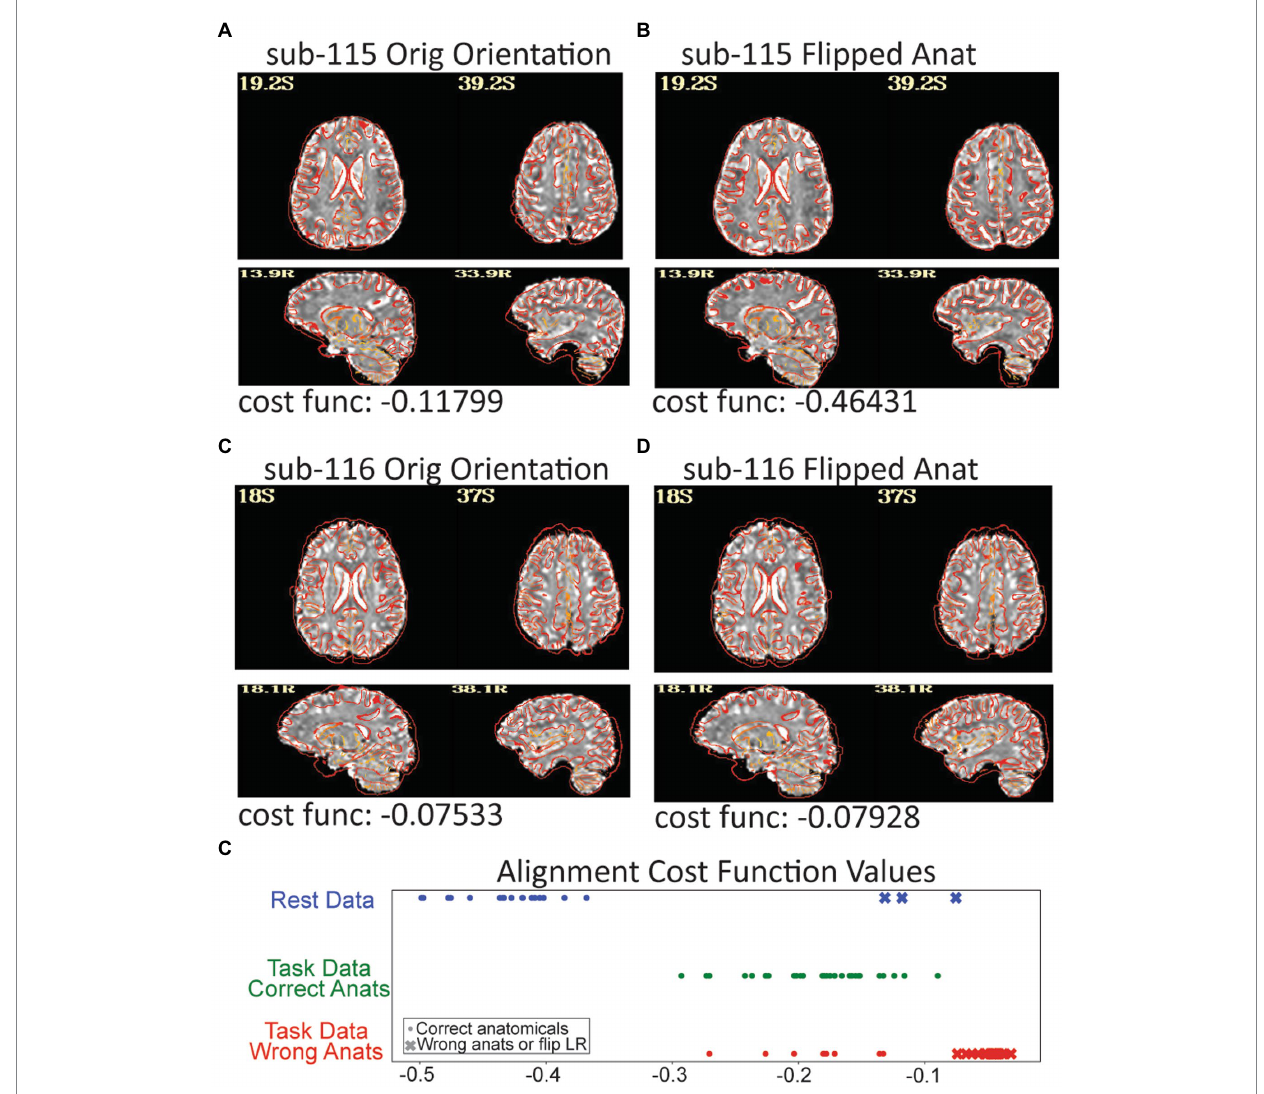
FIGURE 7 Three subjects in the resting data triggered a left–right flip warning which happens when the cost function for anatomical to EPI alignment finds a better local minimum after flipping the anatomical. The grayscale EPI image used for alignment is shown with the edges of the aligned anatomicals. (A) The original alignment for sub-115 looks ok, but (B) shows the alignment for sub-115 with the anatomical image flipped and the gyral edges are clearly better matched. Sub-115 generated a “severe” left–right flip warning. Sub-116 does not have a great alignment for the original (C) or flipped (D) anatomical and generated a “medium” left–right flip warning. Since neither fits well, sub-116 may have been shared with the wrong anatomical image. (E) The cost function minimums for the successful alignments in the rest dataset were − 0.36 to − 0.5 while the 3 flipped alignments were more than − 0.13. Similarly, when the task data were unintentionally aligned to the wrong anatomicals, the cost functions were much higher. While cost functions are relative measures, the values may be useable as an intra-study alignment QC